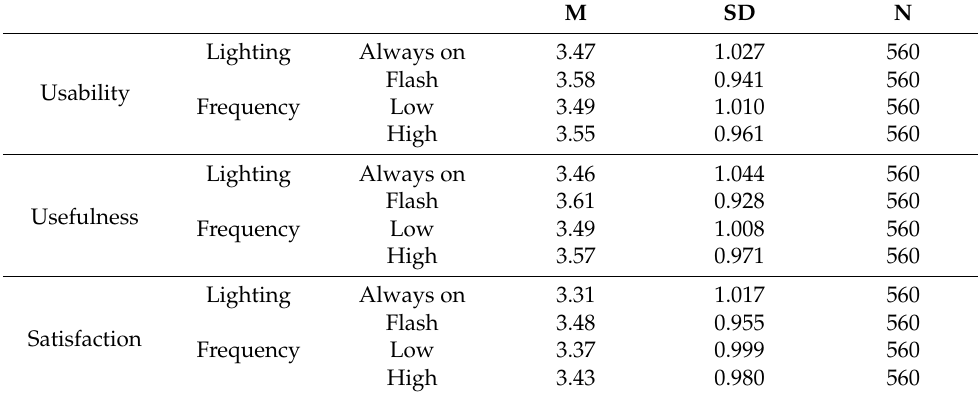
Table 8. Descriptive statistical average of certain factors in deceleration scenario.